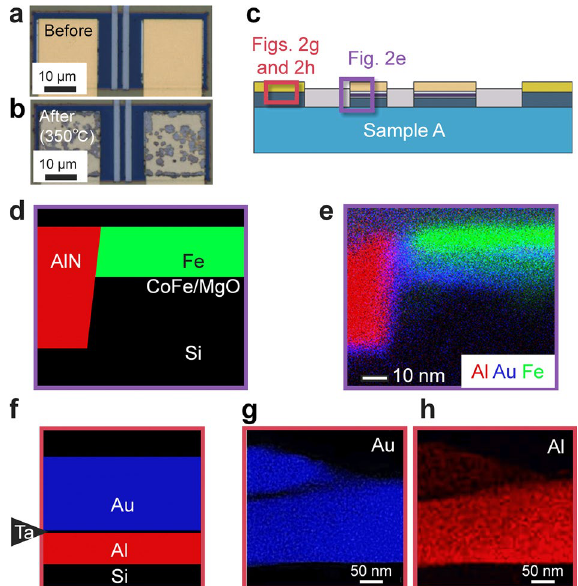
Figure 2. Microscopic pictures of sample A after annealing at 350 °C. ( a , b ) Optical microscopic image ( a ) before and ( b ) after annealing at 350 °C. ( c ) A schematic cross-section of sample A. The areas of EDS observations are roughly indicated by purple and red squares. ( d ) A designed structure and ( e ) an elemental mapping image near the FM electrode indicated by the purple rectangle in (c), where Au, Al and Fe are shown in blue, red and green, respectively. ( f ) Designed structure and e lemental mapping images of ( g ) Au and ( h ) Al near the NM electrode indicated by the red rectangle in